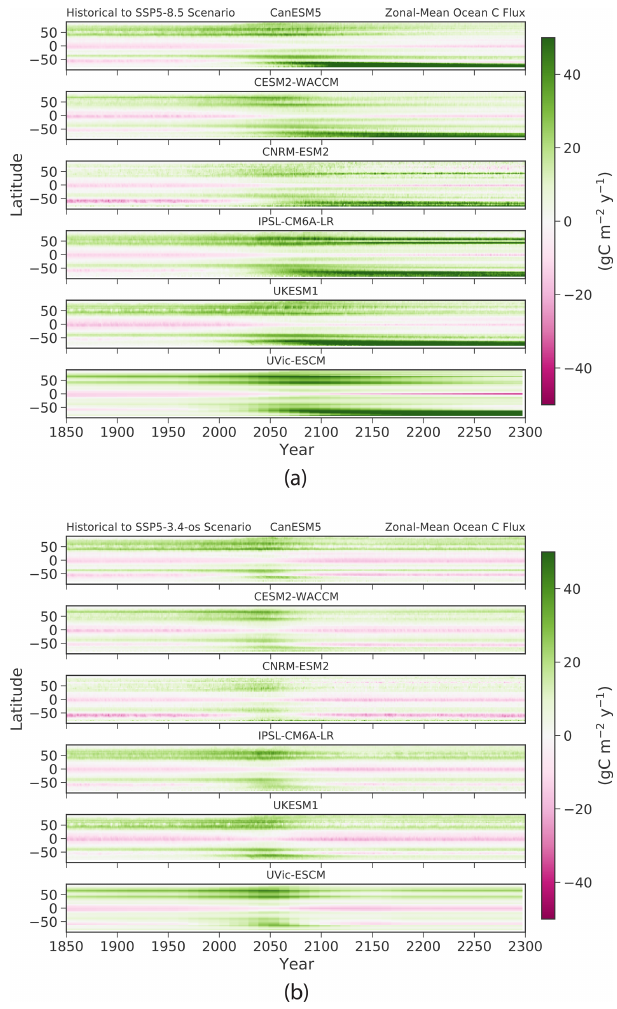
Figure 7. Zonal mean ocean carbon flux dynamics of the six mod- els under (a) the SSP5-8.5 and (b) SSP5-3.4-overshoot scenarios. Positive flux represents a net carbon